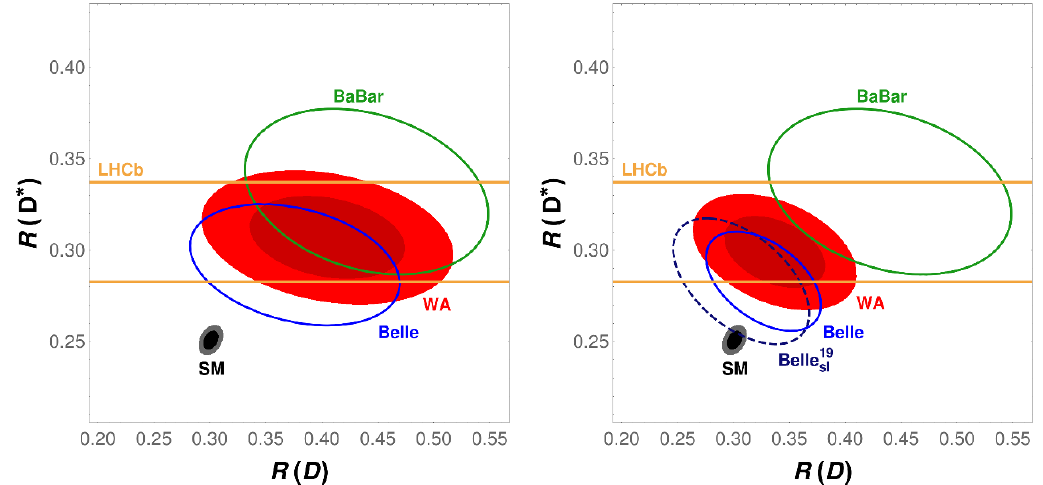
Figure 1 . Measurements for and (cid:3) , averaged for each experiment where applicable (contours R D R D corresponding to 68% CL), our SM prediction and the global average (performed by HFLAV on the left, by us including the new preliminary Belle measurement [71, 72] on the right; (cid:12)lled ellipses correspond to 68 and 95%